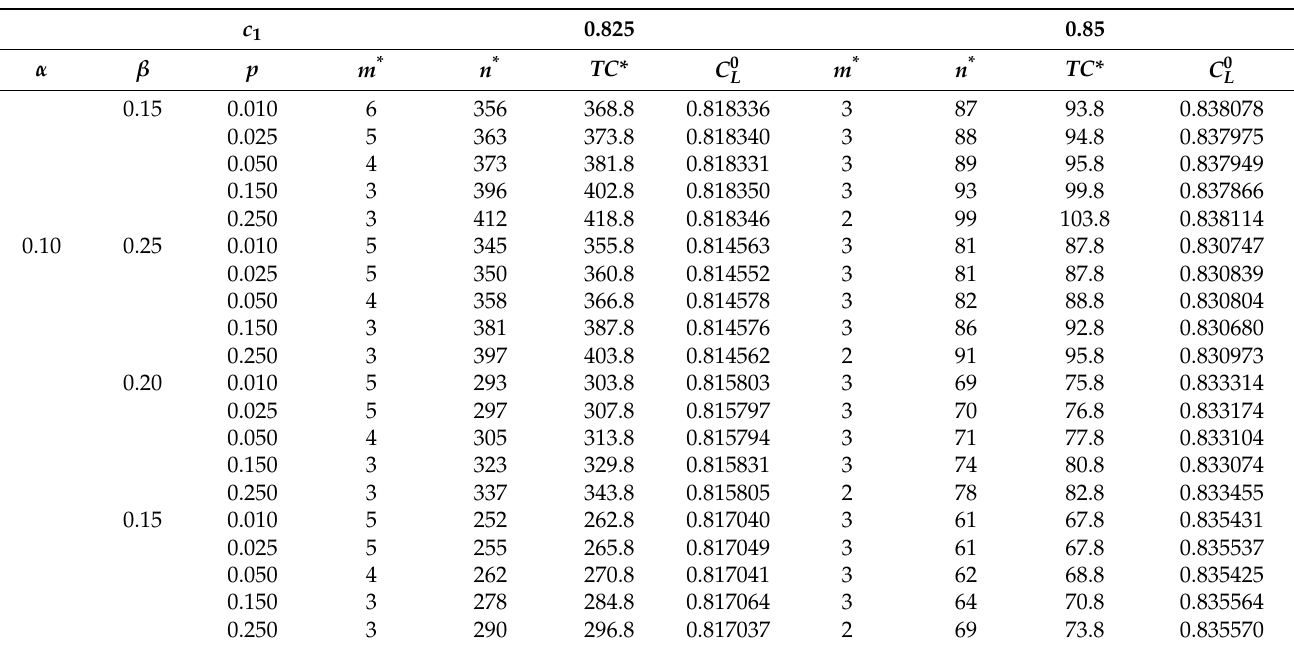
Table A2. The optimal m *, n *, related total cost TC* and the critical value for c 1 = 0.875, 0.90